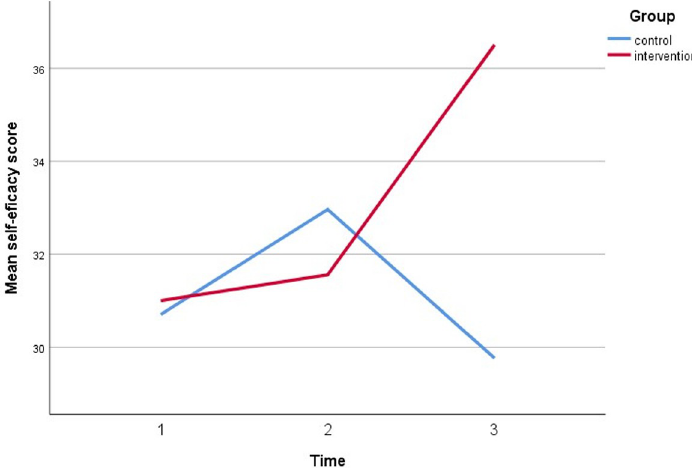
Fig 10. A plot of self-efficacy scores among respondents, showing an interaction between groups and time.